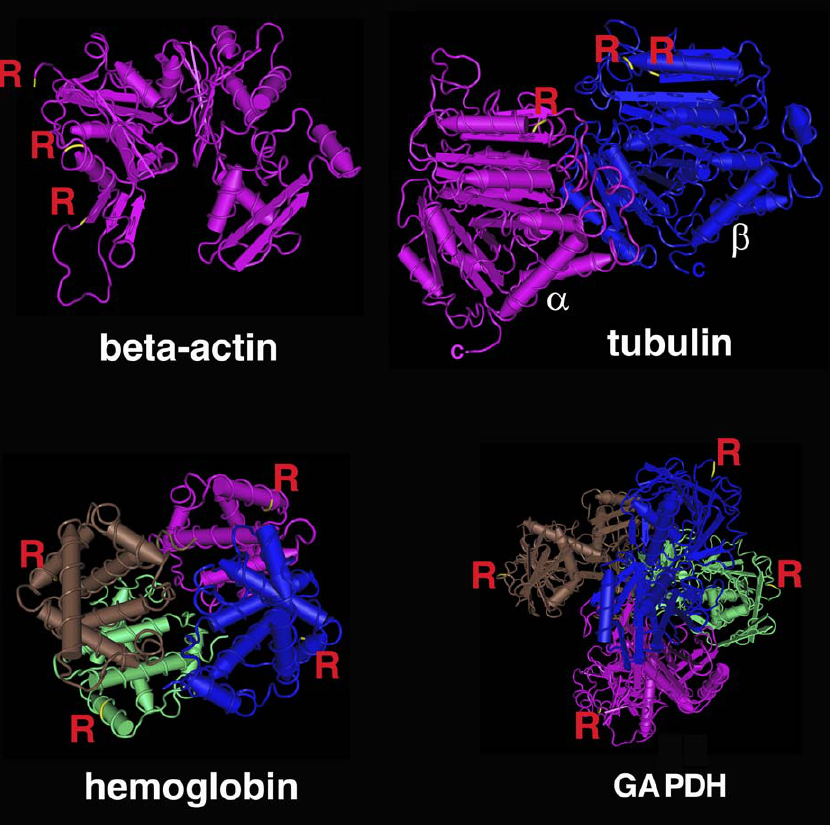
Figure 6. Structural Models of Proteins Regulated by Arginylation Three-dimensional structures of proteins downloaded from the National Center for Biotechnology Information structure database at http://www.ncbi. nlm.nih.gov/ (PDB identifiers 1HLU for beta actin, 1TUB for tubulin, 1DXT for hemoglobin, and 1ZNQ for GADPH) with arginylated positions highlighted in yellow within the polypeptide chains and marked with red letters R. Alpha and beta for tubulin indicate the corresponding polypeptide chains. See Text S1 for explanation of the functional significance of the arginylated sites in each shown